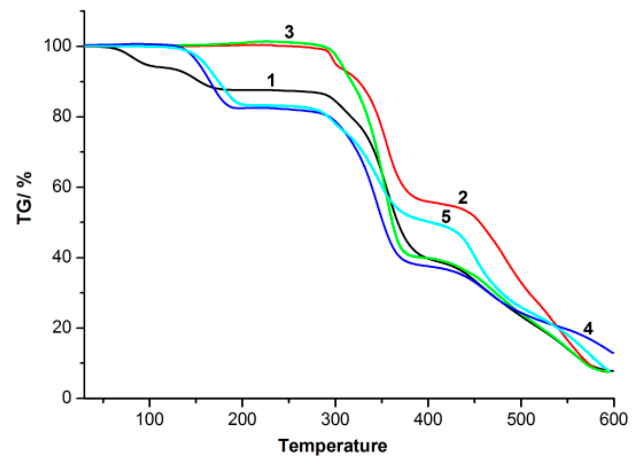
Figure 7. TG curves of compounds ( 1 )–( 5 ).